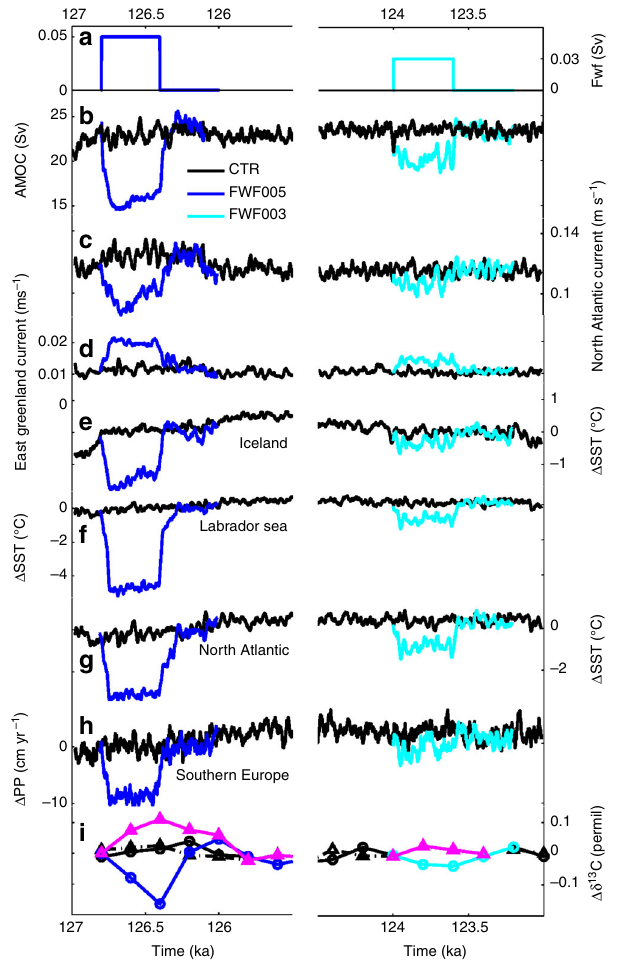
Fig. 5 Results of a suite of LOVECLIM experiments performed under LIG conditions. Control experiment is shown in black and experiments where 0.05 Sv (FWF005) and 0.03 Sv (FWF003) of freshwater was added to the area south of Greenland for 400 years are shown in blue and cyan, respectively (see Methods). Time series of: a meltwater input in the North Atlantic; b maximum overturning circulation in the North Atlantic; c North Atlantic